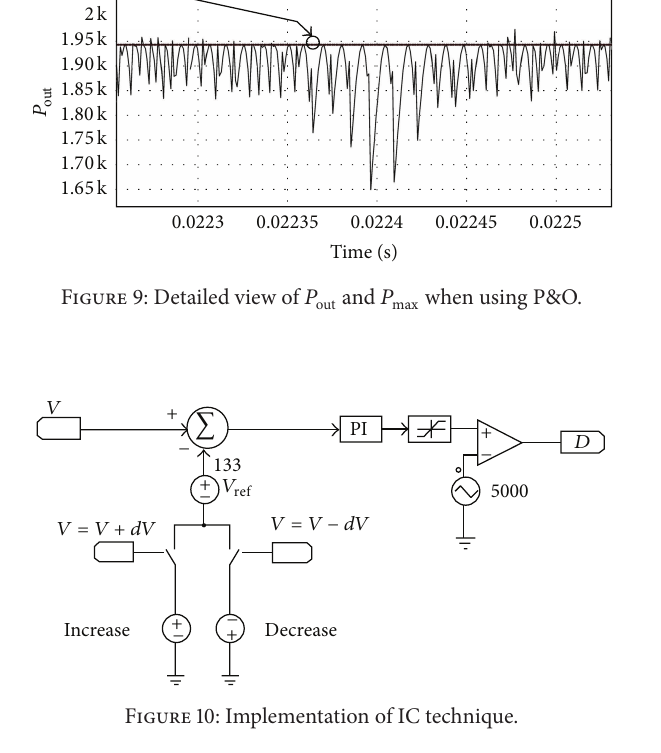
Table 7: Efficiency obtained for the IC technique under distinct operating conditions.